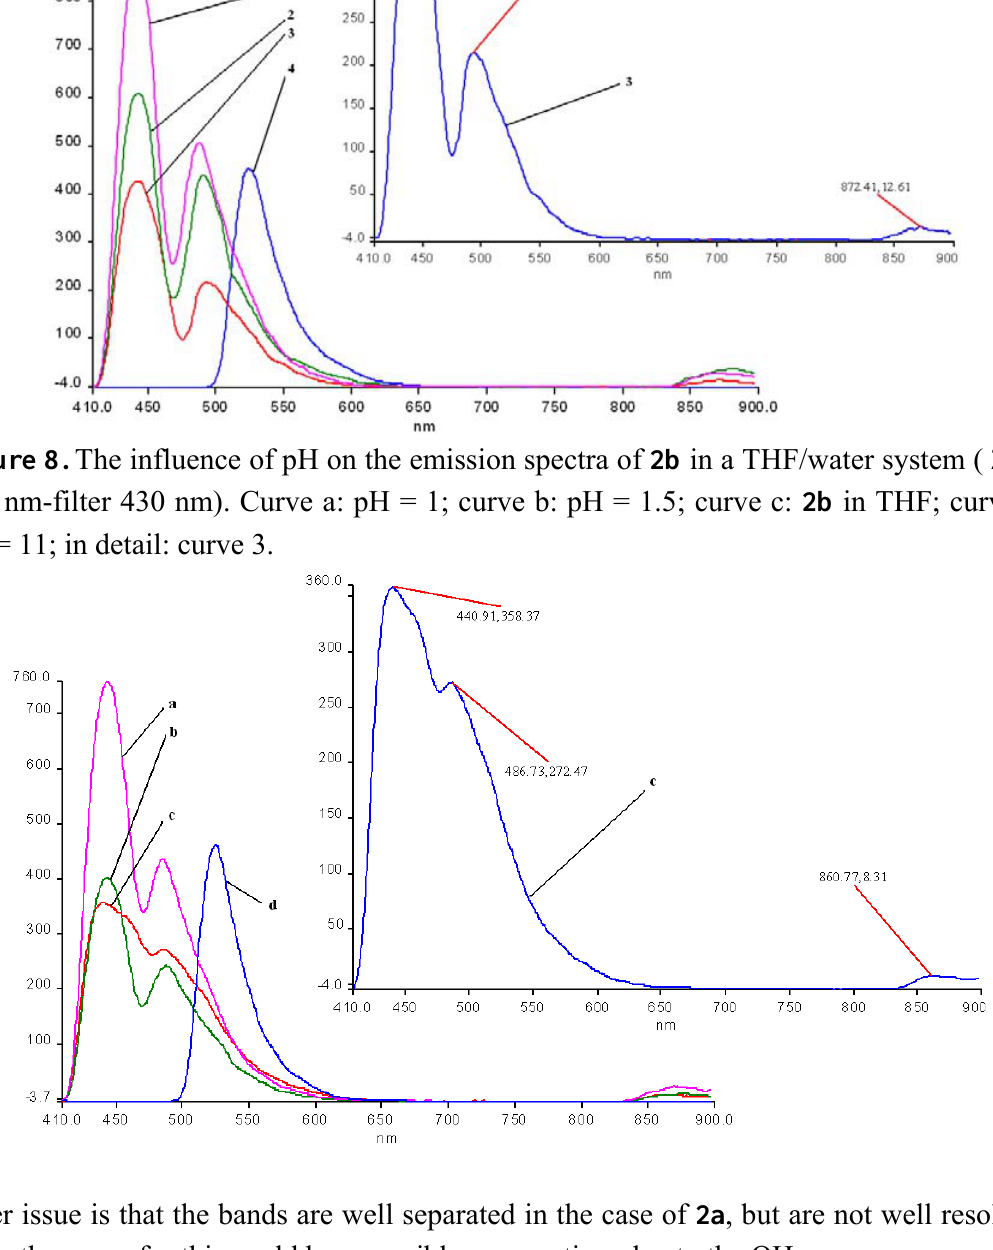
Figure 7. The influence of pH on the emission spectra of 2a in a THF/water systems ( λ 250 nm-filter 430 nm). Curve 1: pH = 1.0; curve 2: pH = 1.5; curve 3: 2a in THF; curve 4: pH = 11; in detail: curve 3.